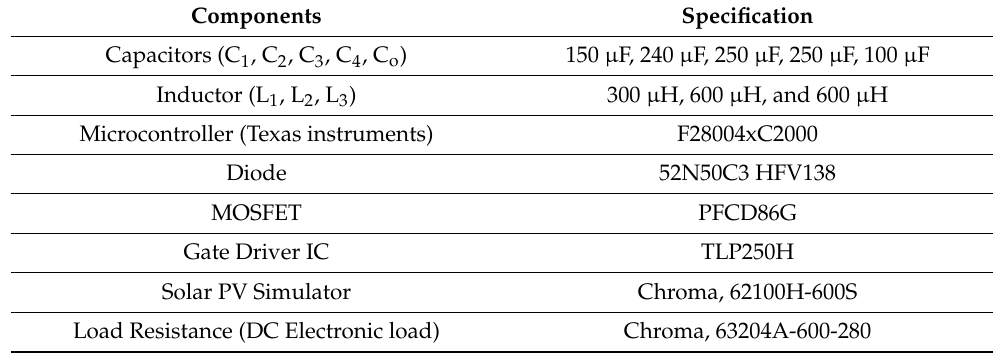
Figure 15. ( a ) Experimental testbed of the proposed HGVSU converter in a power and energy labor- atory, and ( b ) hardware prototype of the proposed HGVSU converter.